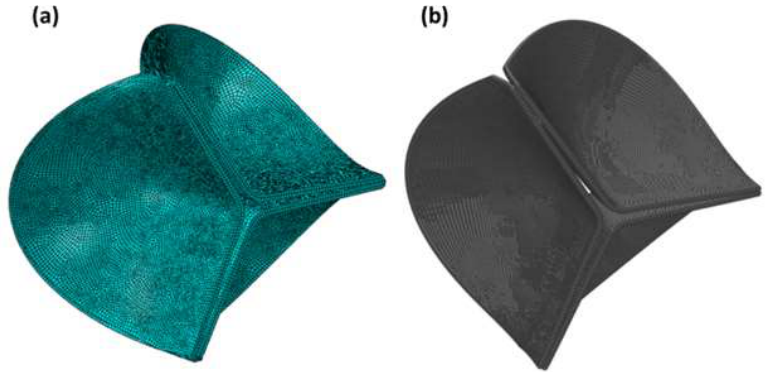
Figure A1. Mesh generation using a pre-processing solver ( a ) and the generated particle distribution ( b ).